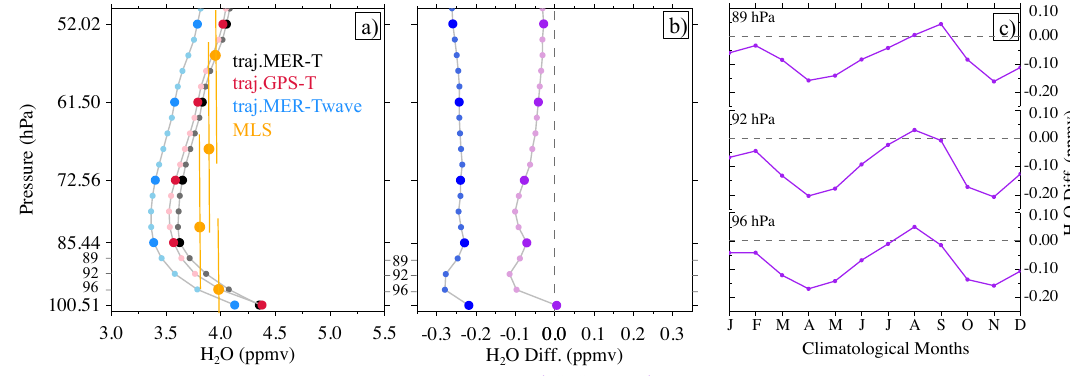
Figure 7. (a) Trajectory predicted H 2 O compared with MLS observations (the vertical bars in orange indicate the MLS vertical resolutions at each of the MLS retrieval pressure levels); (b) trajectory H 2 O differences induced by waves (blue) and by using GPS temperatures (purple); (c) annual differences at 96, 92, and 89hPa. All values are averaged over the deep tropics (18 ◦ S–18 ◦ N) in 2007–2013, with larger dots marking the MERRA model levels and small dots marking the MERRA in-between levels – the levels where the cold-point tropopause could have been found but were not available in the current MERRA vertical